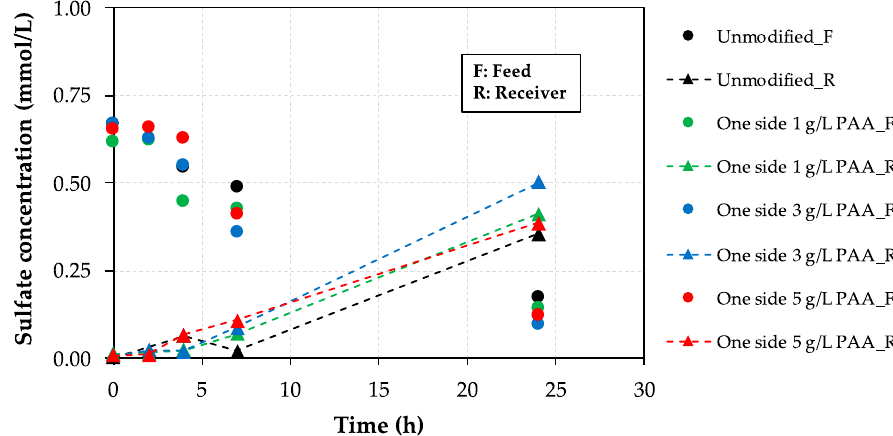
Figure 9. HA studies: sulfate evolution with time during mass transport experiments as a function of the one side modified AEM used.